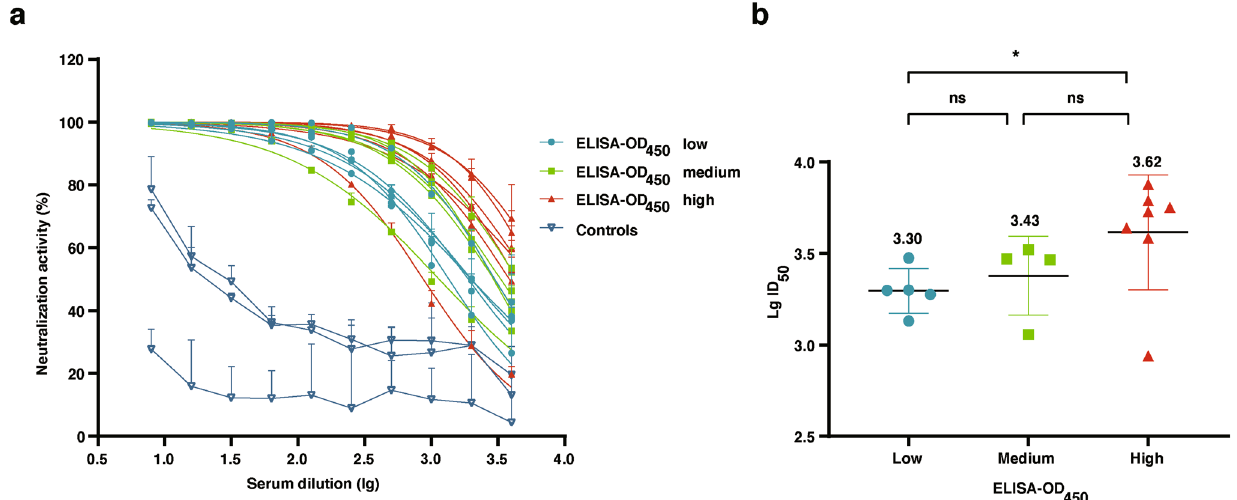
Figure 5. Application of CHIKV PsV micro-neutralization assay in human serum samples. CHIKV PsV neutralization assay was performed with two-fold serial dilutions of CHIKV convalescent human sera. Luciferase activity was measured at 72 h post-transduction of CHIKV PsV. A total of 20 serum samples were used, 17 of them were obtained from CHIKV-positive patients, while 3 serum samples were from CHIKV- negative patients as negative controls. (a) The inhibition curves of human serum samples on CHIKV PsV. ID 50 as neutralizing titer was calculated via the software Prism Graphpad 8.0.2. Error bars show the standard deviations (SD) of results from three independent experiments. (b) Correlation between ELISA-OD 450 groups and CHIKV PsV LgID 50 . The statistical significance analysis was performed by Student’s t test. P values of < 0.05 ( * ) were considered as statistically significant. The mean LgID 50 is given on the